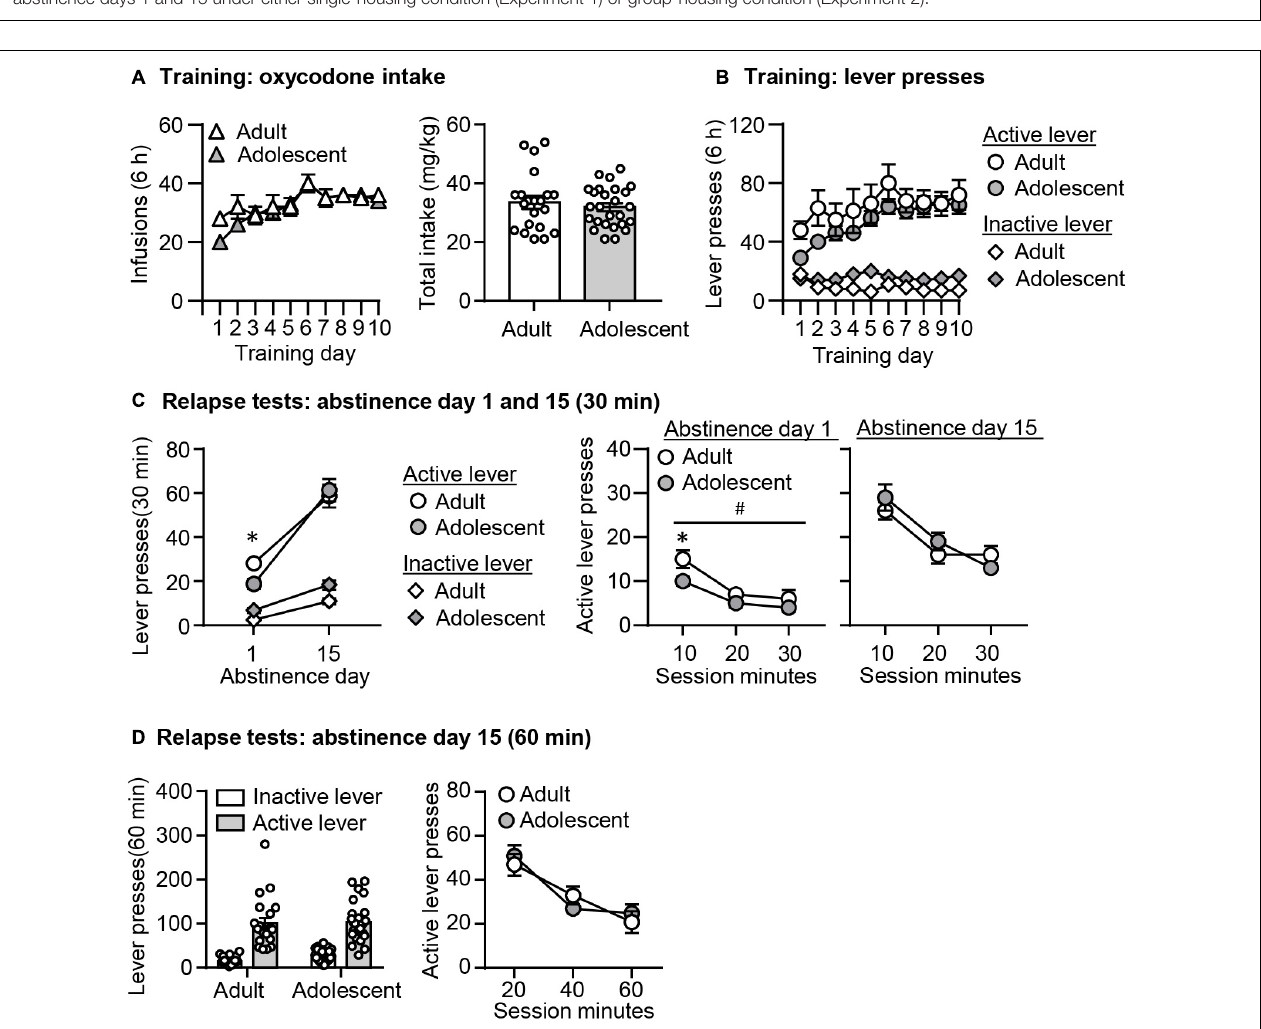
FIGURE 2 | Incubation of oxycodone craving following adult-onset and adolescent-onset oxycodone self-administration under the single-housing condition. (A,B) Data are mean ± SEM number of oxycodone (0.1 mg/kg/infusion) infusions, total oxycodone intake, and lever presses during the ten 6-h daily self-administration sessions for Exp. 1. During training, active lever presses were reinforced on an FR1 20-s timeout reinforcement schedule, and oxycodone infusions were paired with a 5-s tone-light cue. (C) Relapse test on abstinence days 1 and 15: Data are mean ± SEM of active and inactive lever presses during the 30-min relapse test on abstinence day 1 and the first 30 min of the 60-min relapse test on abstinence day 15. # Main effect of Age; *Different from Adult, p < 0.05. (D) Relapse test on abstinence day 15: Data are mean ± SEM of active and inactive lever presses during the 60-min relapse test. During testing, active lever presses led to contingent presentations of the tone-light cue previously paired with oxycodone infusions during training, but not oxycodone. n =